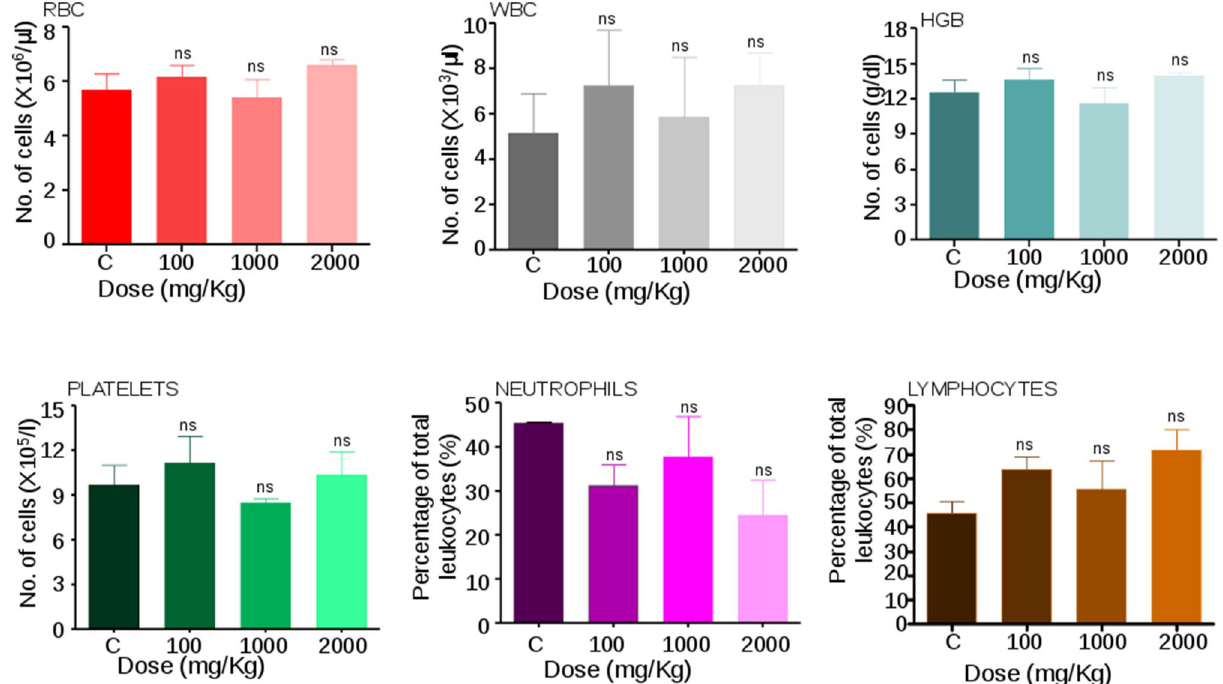
Figure 5. Blood parameter analysis following oral administration of Disarib in rats. Analysis of red blood corpuscles (RBC), white blood corpuscle (WBC), haemoglobin (HGB), Platelets, Neutrophils, Lymphocytes count among control and Disarib treated groups (100, 1000, 2000 mg/kg b. wt) after 14 days of dose administration. Error bars denote mean + SEM ( ns not significant).